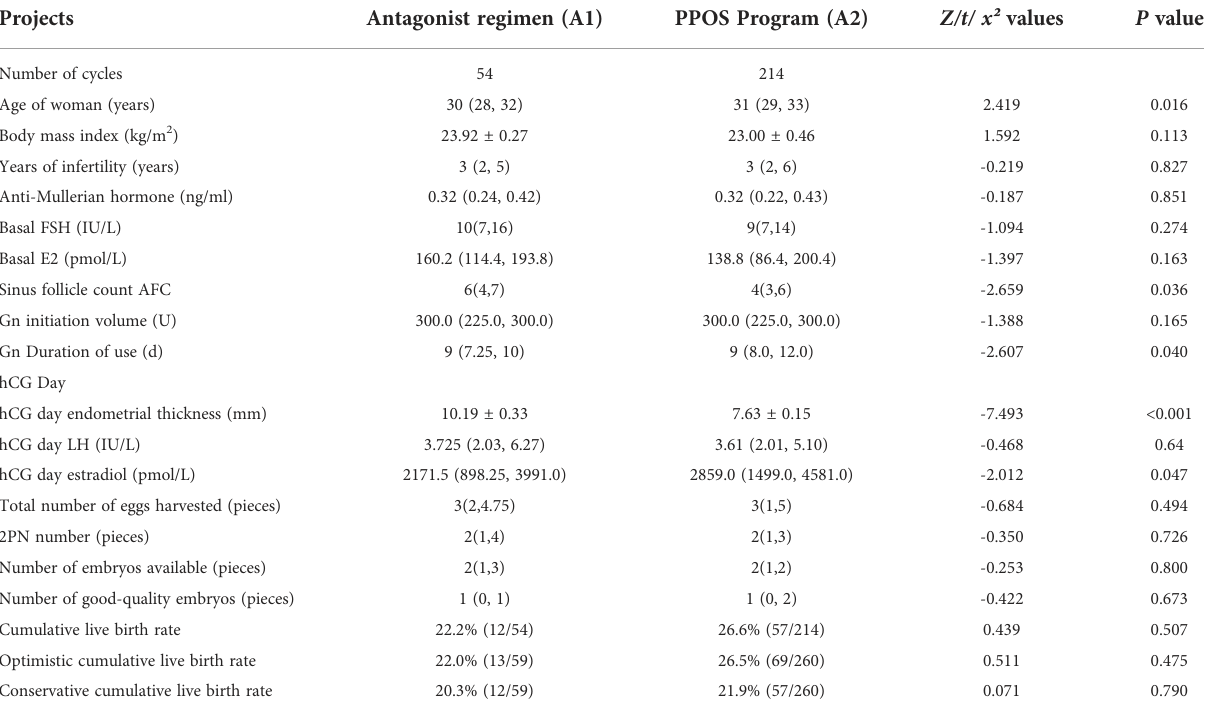
TABLE 3 Group A patients Comparison of basic clinical information and laboratory results [ x ˉ ± s , M(Q1, Q3)]. Projects